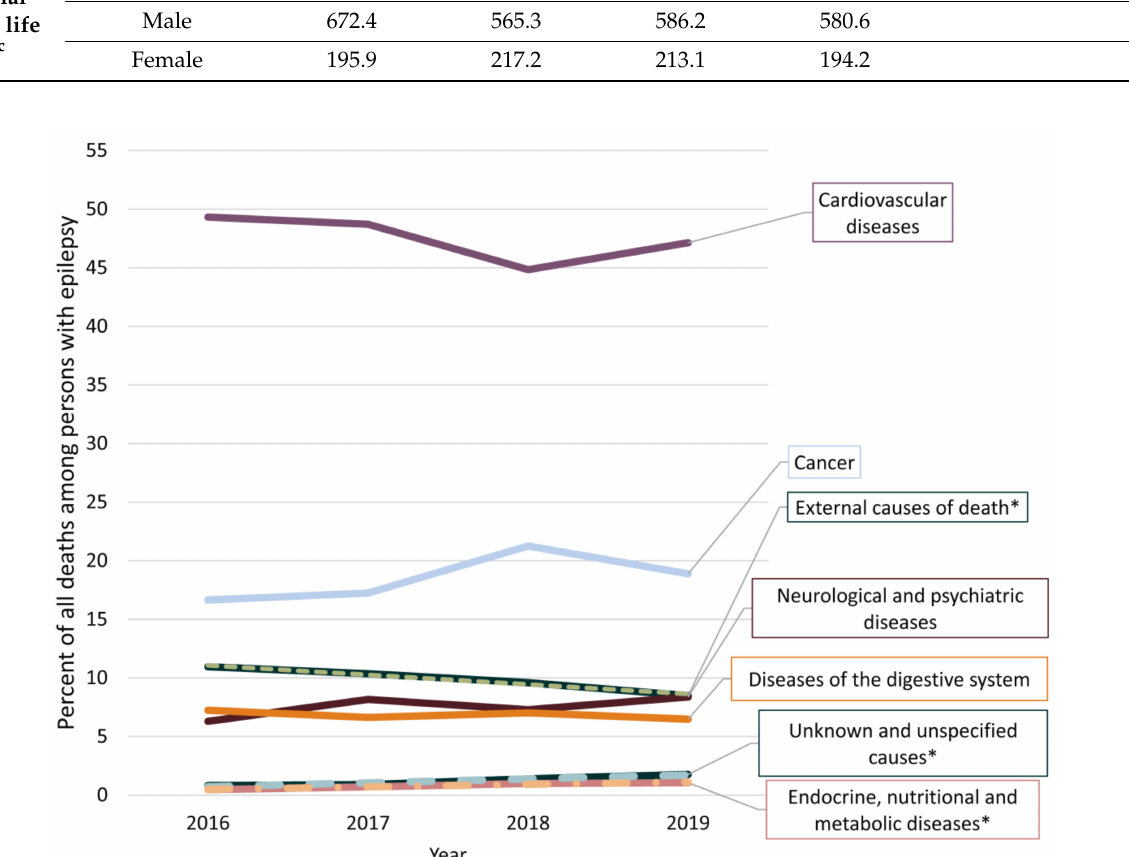
Figure 3. The most frequent causes of death among people with epilepsy every year. Only causes of death surpassing 5% or having trends are represented. * causes of death trending between 2016 and